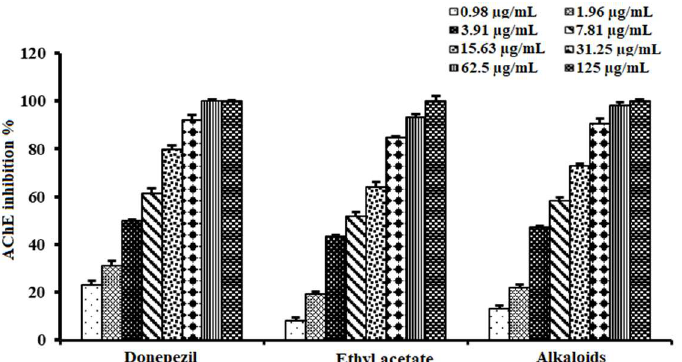
Figure 5. Acetylcholinesterase inhibitory activity of alkaloids from ethyl acetate fraction of A. lucidior , compared to donepezil. Values are expressed as mean ± S.D.